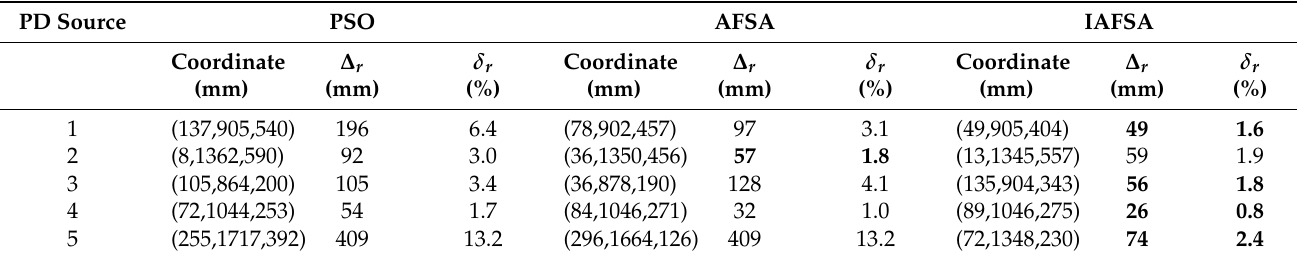
Table 9. Localization results and errors from laboratory